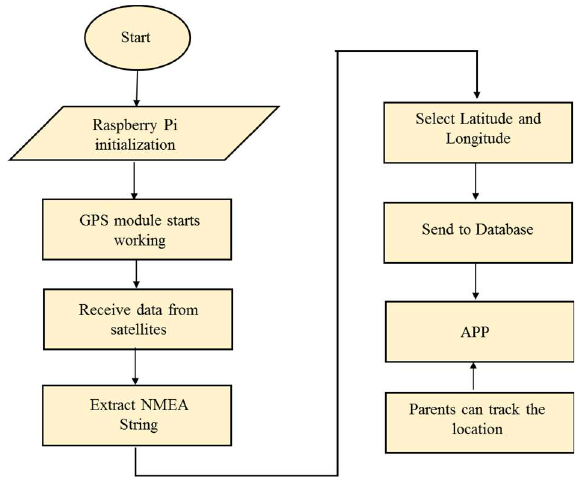
Figure 5. Flow chart of getting location information.